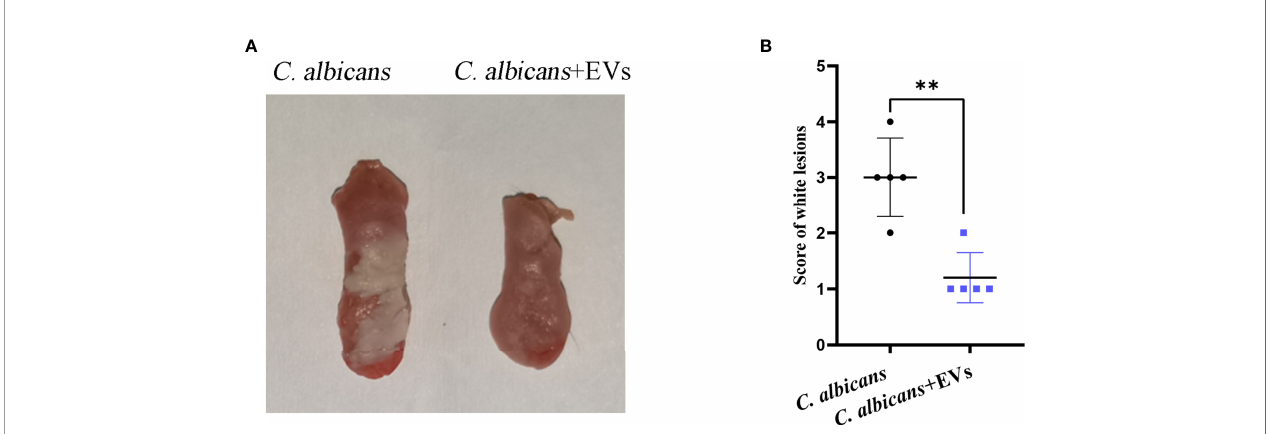
FIGURE 8 | Macroscopic observation and lesion score analysis of mouse model of C. albicans infection. (A) Macroscopic observation of typical white lesions on the tongue of oral candidiasis mice. (B) Difference in the scores of white lesions between the C. albicans group and C. albicans + EVs group. Statistical signi fi cance was tested by Student ’ s t-test. **P <